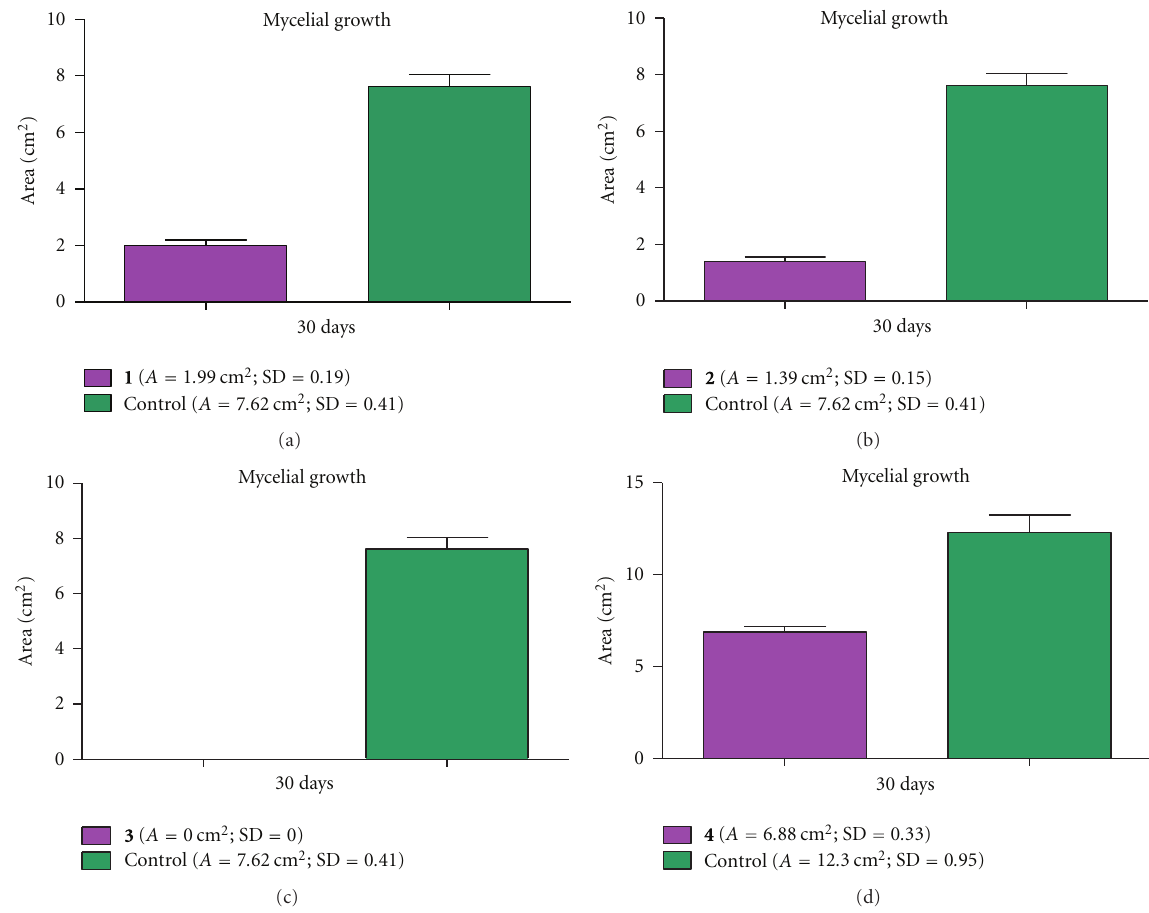
Figure 3: E ff ect of the compounds (+)-sesamin ( 1 ) (100 μ g · mL − 1 ), ( − )-hinokinin ( 2 ) (100 μ g · mL − 1 ), ( − )-kusunokinin ( 3 ) (120 μ g · mL − 1 ), and quercetin-3- O - α -L-rhamnoside ( 4 ) (100 μ g · mL − 1 ) [18] on the mycelial growth of the symbiotic fungus L. gongylophorus .